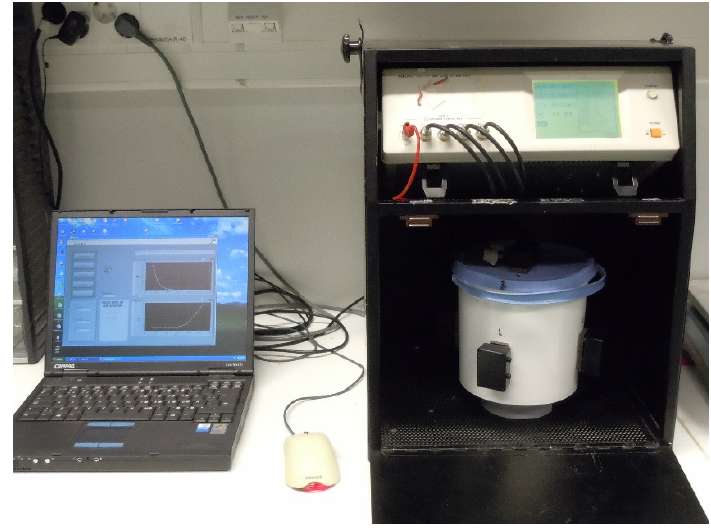
Figure 2. EIS measurement system: Portable PC, Hioki 3531Z HiTester impedance analyser and measurement container.